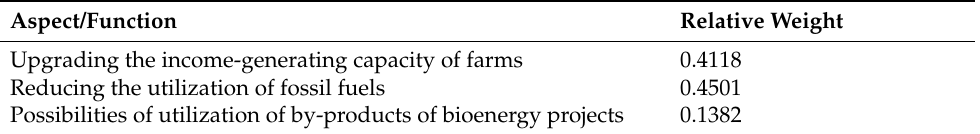
Table 9. Results of the AHP on weighting the relative importance of the economic dimensions of bioenergy